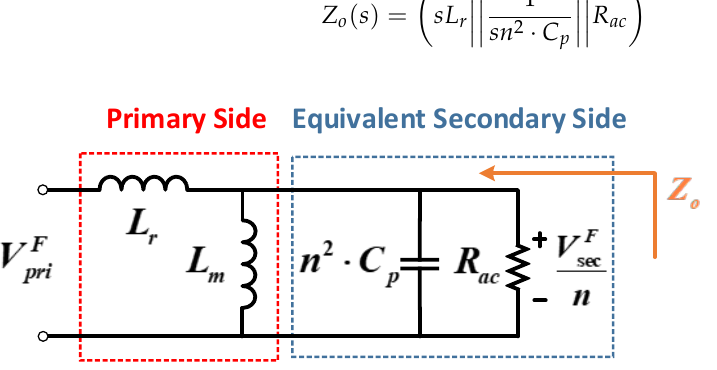
Figure 5. AC equivalent circuit of the proposed parallel resonant converter.